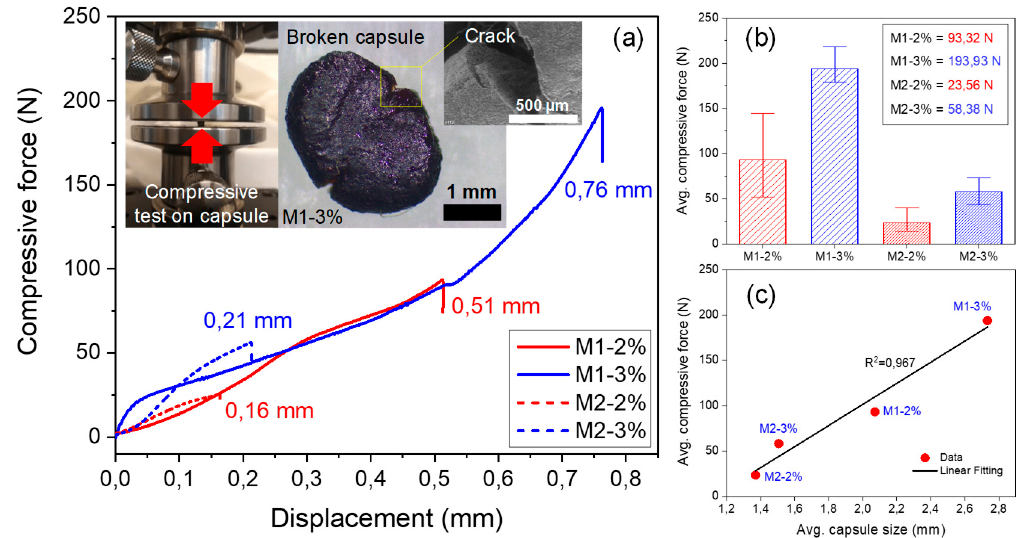
Figure 7. ( a ) Average curves of the compressive force versus displacement of the BO capsules tested following the recommendations of the ASTM D695-02a [24], including image details of the mechanical test, broken capsule, and crack type; ( b ) average results of maximum compressive force of capsules with St. Dev. error bars; ( c ) linear correlation between compressive force and capsule size.